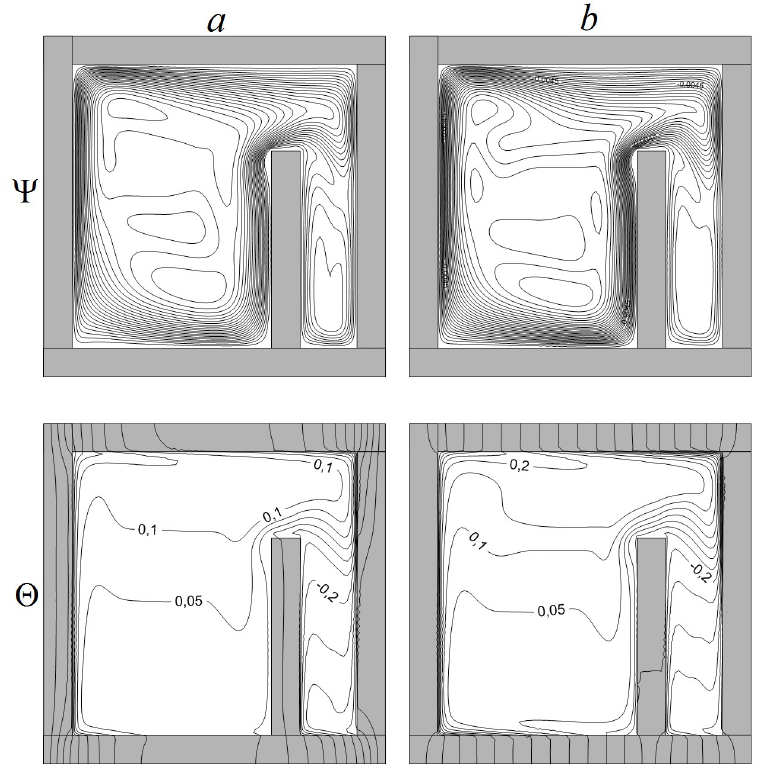
Figure 9. Isolines of Ψ and Θ at 0.9    , Ra = 10 9 , Pr = 0.7, h/L = 0.7: λ w,air = 100 ( a ), λ w,air = 1000 ( b ).